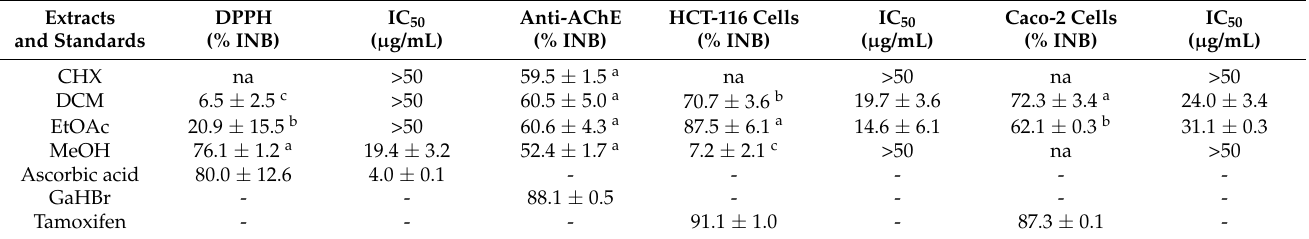
Table 3. Antioxidant and biological activities of S. fruticosa extracts tested at 50 µ g/mL. Extracts and